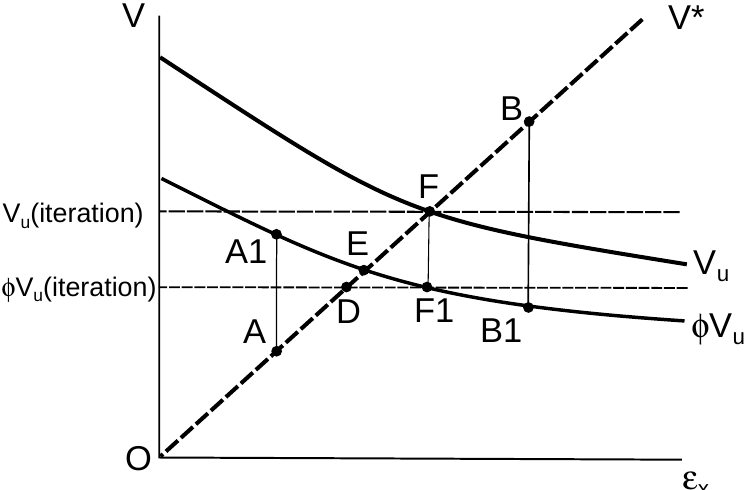
Figure 14. Adverse effects of finding ultimate shear using proportionally increased total load shear.